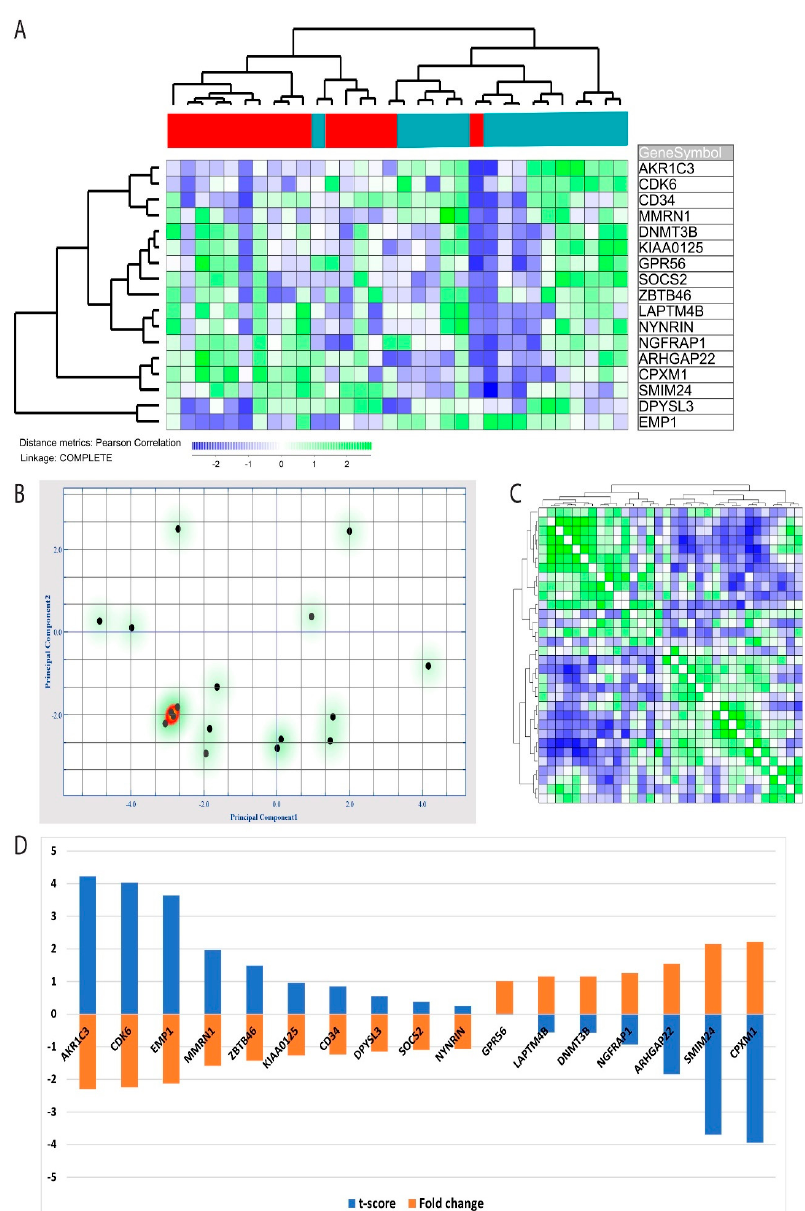
Figure 5. Alteration in acute myelogenous leukemia (AML) leukemia stem cell (LSC) gene expression profile (GEP) AML LSC GEP by nuclear factor- κ B (NF- κ B) inhibition: An LSC gene expression